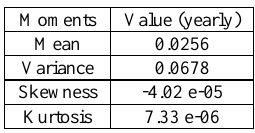
Table 8. Performance of the optimal portfolio for March